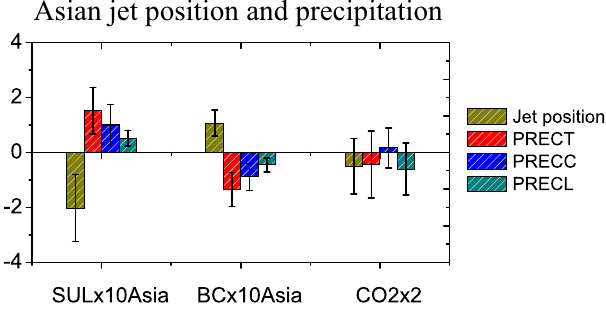
Fig. 4 Changes in Asian westerly jet stream position and precipitation over the arid Central Asia (ACA) induced by individual climate forcers. Asian sulfate (SULx10Asia) and black carbon (BCx10Asia), as well as GHGs (CO2x2) induced changes for the multi-model mean (MMM) in JJA westerly jet position (degree), JJA total precipitation (PRECT, 10 − 1 mm day − 1 ), convective precipitation (PRECC, 10 − 1 mm day − 1 ), and large-scale precipitation (PRECL, 10 − 1 mm day − 1 ) over ACA. Error bars of MMM represent the standard deviation among the PDRMIP